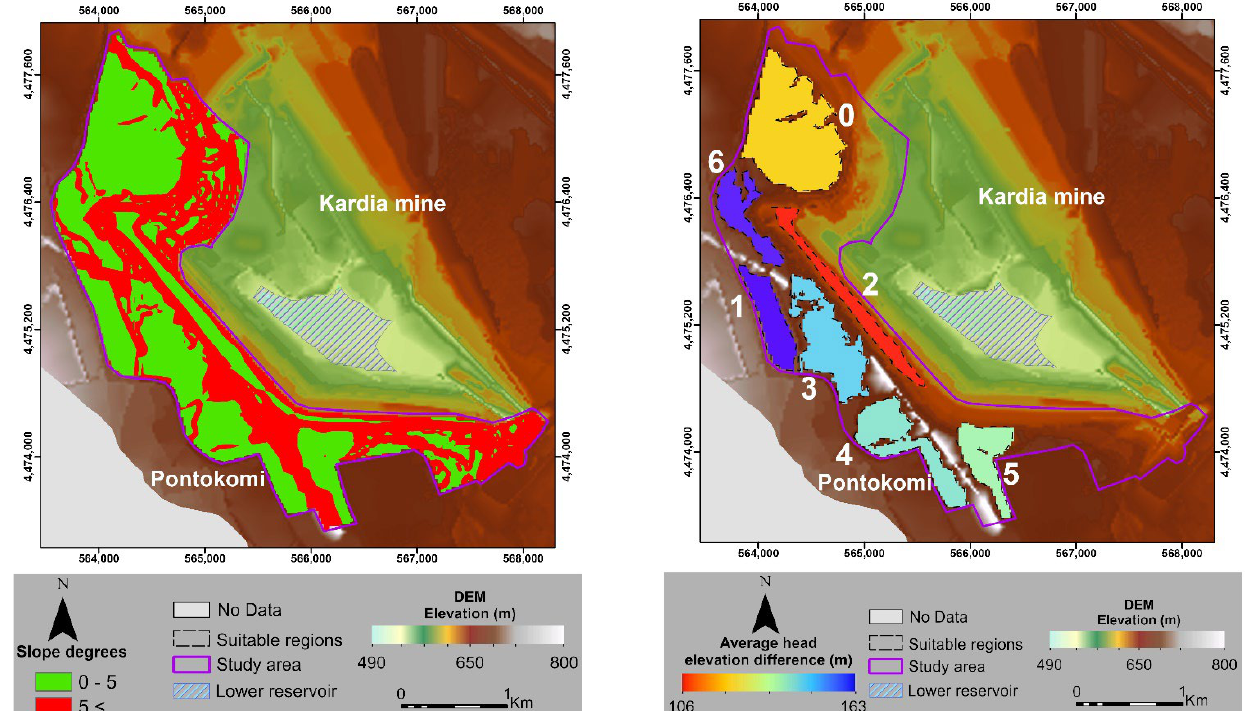
Figure 7. Constraint of slope analysis ( left ), where green color corresponds to the areas of acceptable flatness and red color to unsuitable ones. Average head elevation difference ( right ), where blue color illustrates the highest differences and red color the lowest ones.